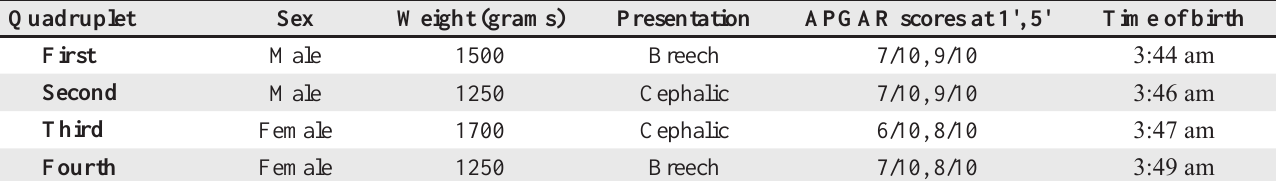
Table 1 : Details of the four babies at time of